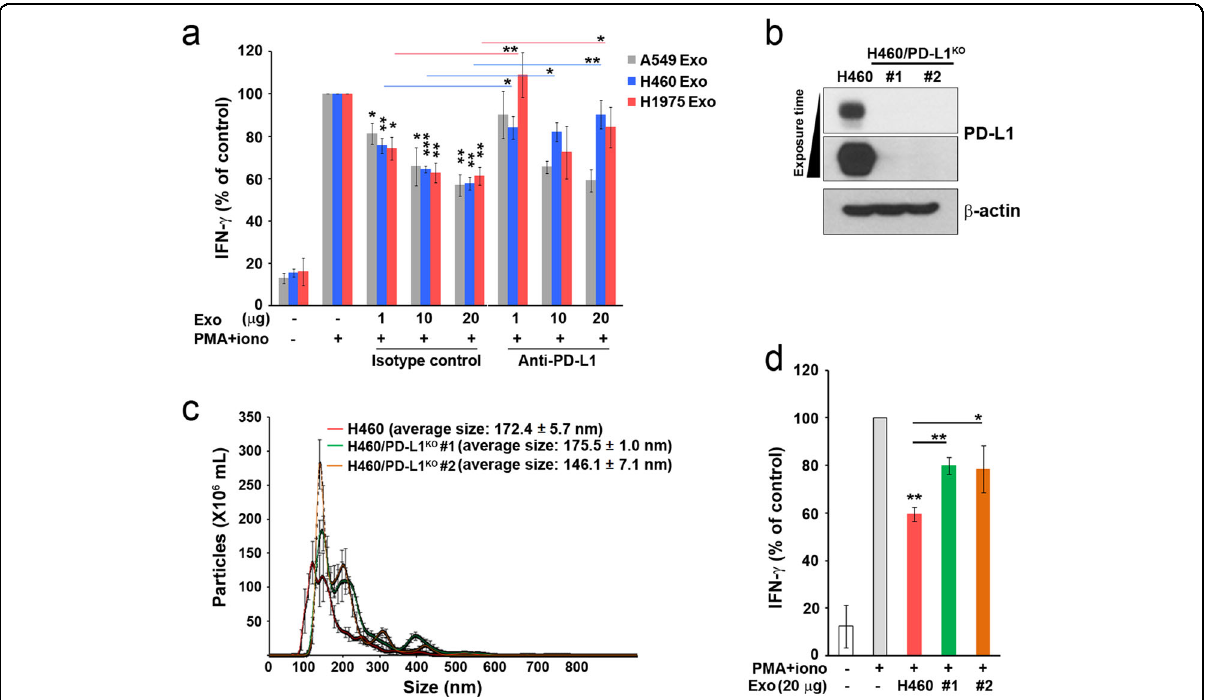
Fig. 3 PD-L1-containing exosomes inhibit INF- γ production in Jurkat cells. a Jurkat cells were treated with the indicated exosomes for 4 h in the presence of PMA (50 ng mL – 1 ) and ionomycin (500 ng mL – 1 ) after PD-L1 masking within the exosomes through treatment with control or anti-PD-L1 antibodies for 30 min. IFN- γ production was measured by ELISA. b H460/PD-L1 KO cells were generated as described in the methods. PD-L1 expression was con fi rmed by western blot analysis. c Nanoparticle tracking analysis (NTA) of H460 cell-derived and H460/PD-L1 KO cell-derived exosomes. d Jurkat cells were treated with H460-derived or H460/PD-L1 KO cell-derived exosomes for 4 h in the presence of PMA (50 ng mL – 1 ) and ionomycin (500ng mL – 1 ), and IFN- γ production was then measured by ELISA. The results are from three experiments. All data are presented as the means ± standard deviations. * P < 0.05, ** P < 0.005, and *** P < 0.0005 by a paired two-tailed Student ’ s t